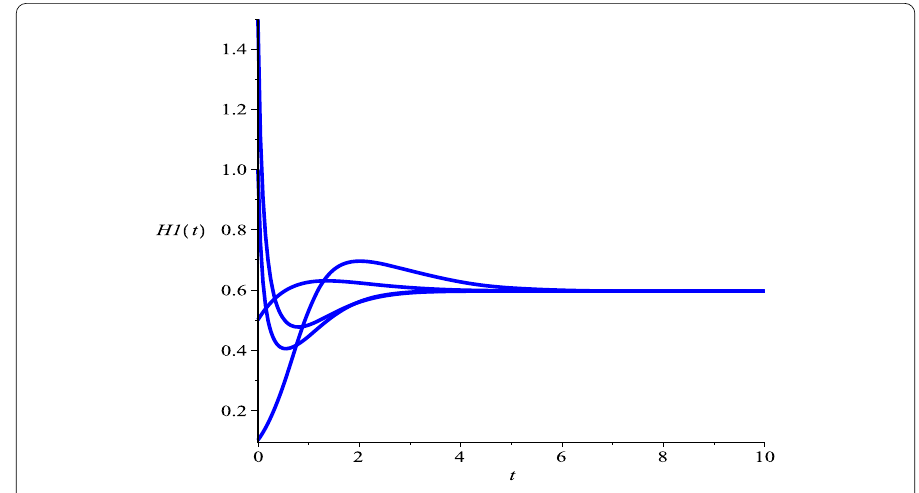
Figure 1 Dynamic behaviors of the strong partners in system (5.1). The initial conditions ( H